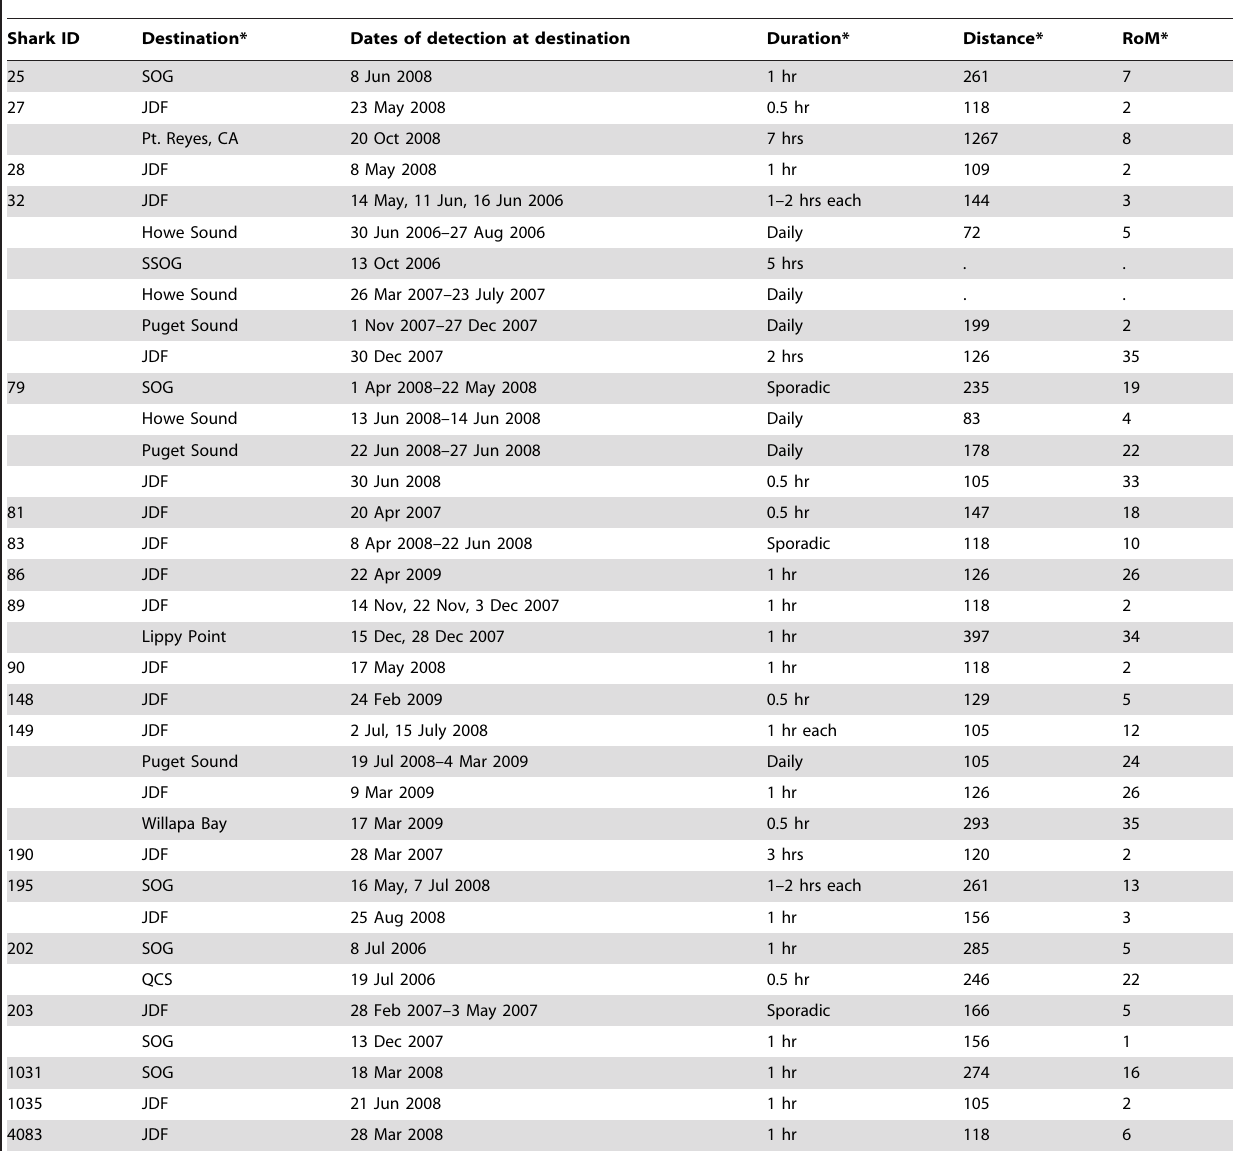
Table 2. Detections of sixgill sharks outside Puget Sound by POST* acoustic receiver